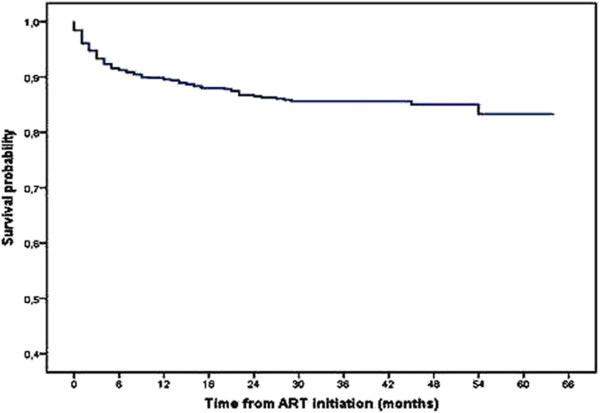
Kaplan-Meier survival curve of 1024 adult HIV-infected patients on ART.